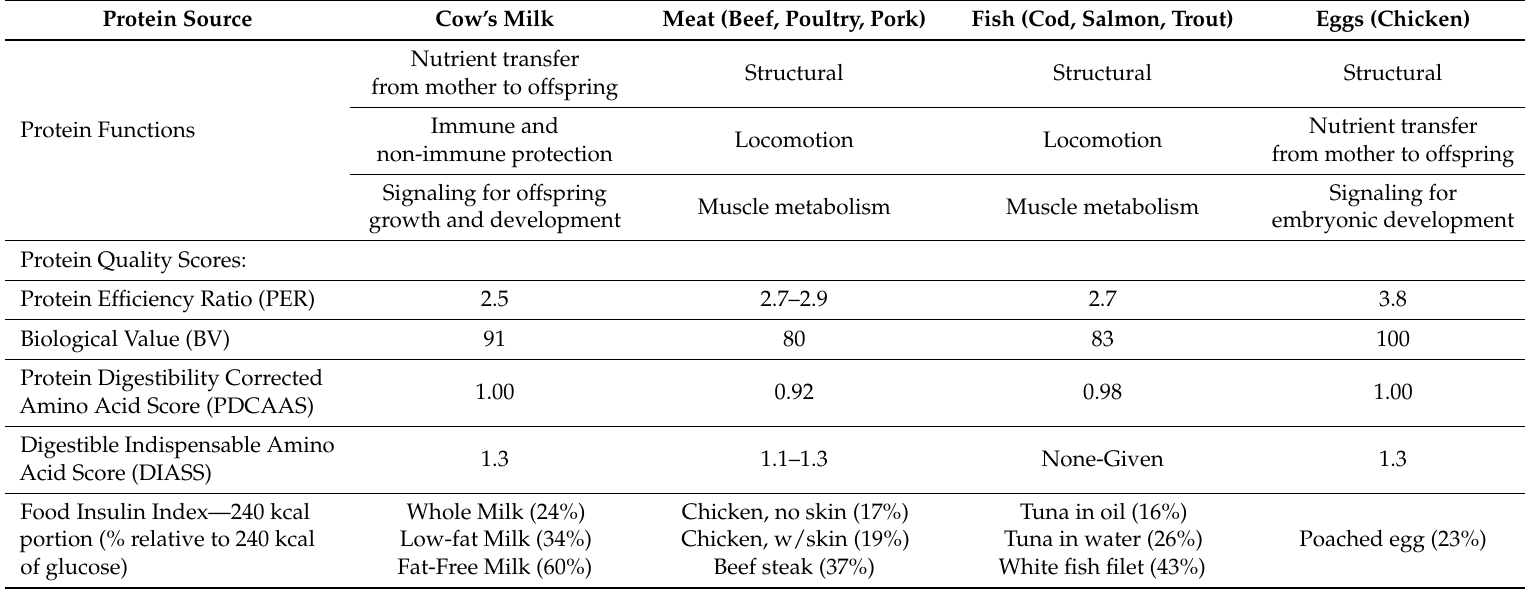
Table 2. Functional and qualitative differences between commonly consumed animal proteins. Protein Source Cow’s Milk Nutrient transfer Structural Structural Structural from mother to offspring Immune and Protein Functions Locomotion Locomotion non-immune protection Signaling for offspring Muscle metabolism Muscle metabolism growth and development